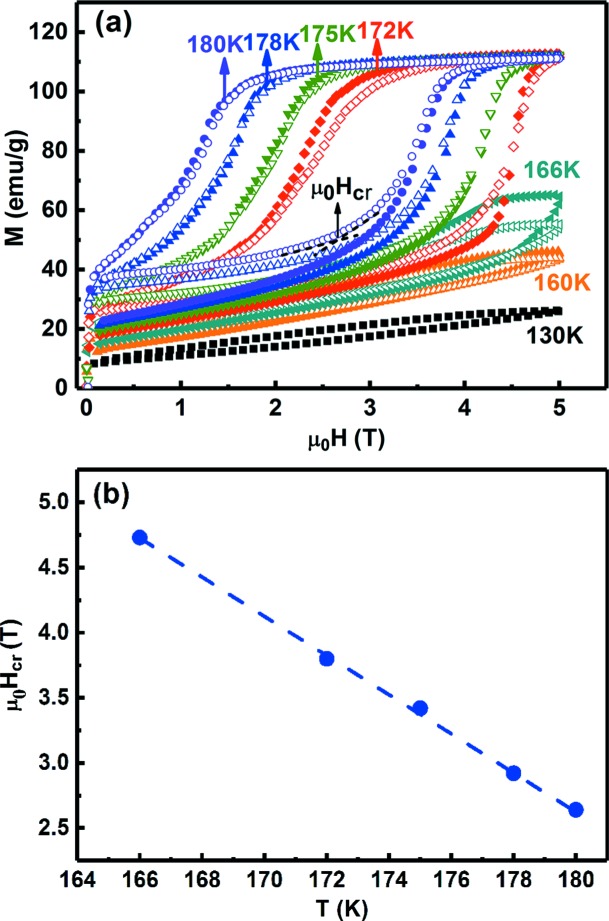
(a) M(H) curves measured during the first (open symbols) and second (solid symbols) cycles of increasing and decreasing field at different temperatures for the Ni43.7Cu1.5Co5.1Mn36.7In13 microwire. The determination of the critical field (μ0
H
cr) for the magnetic field-induced phase transition is illustrated in the figure. (b) The temperature dependence of the critical field (μ0
H
cr) extracted from the second cycle of M(H) curves in panel (a). The dashed line is the linear fit line of the data (shown as symbols).